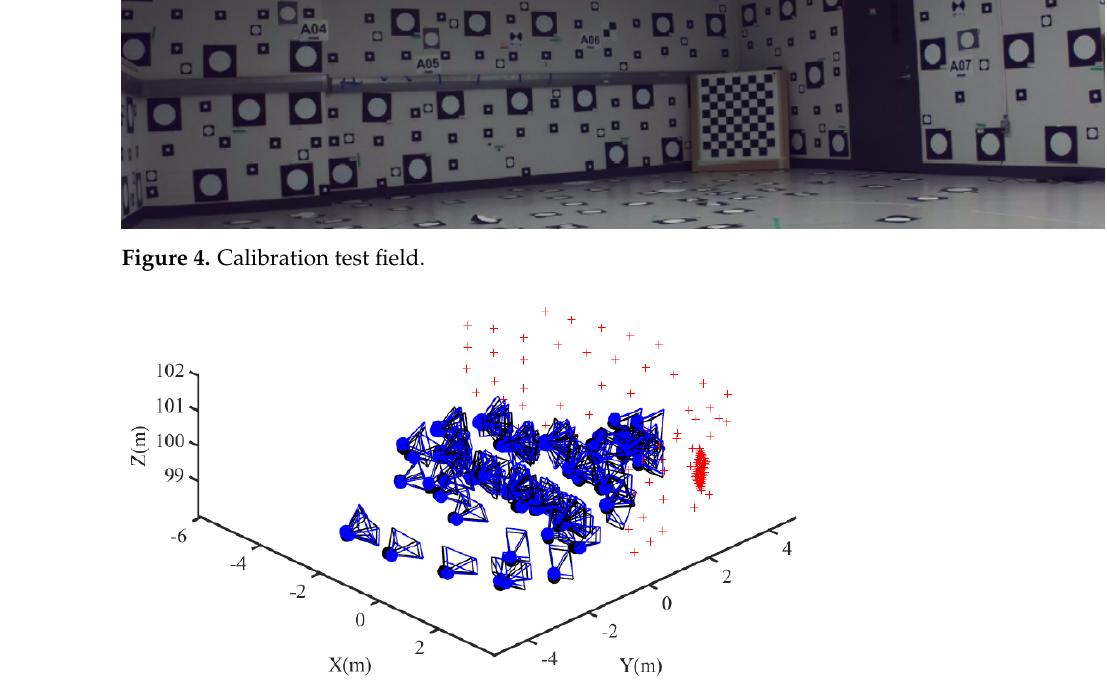
Figure 5. Network of calibration image pairs.